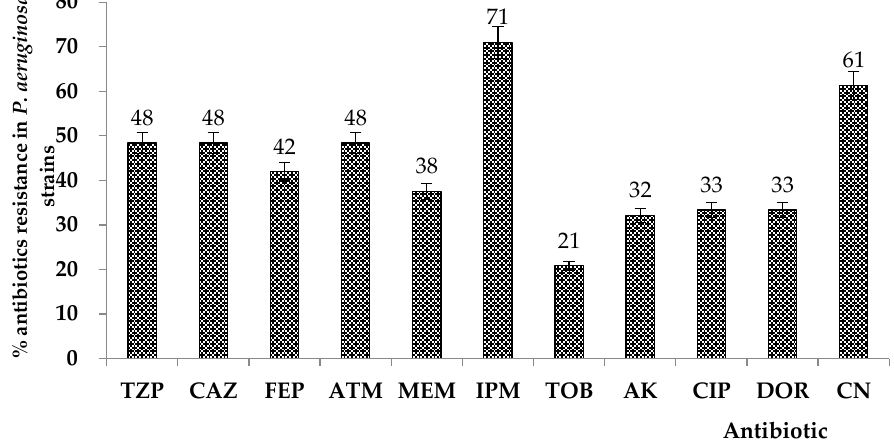
Figure 1. Results of antibiotic resistance of Pseudomonas aeruginosa -evaluated strains ( n = 36). (TZP: piperacillin/tazobactam; CAZ: ceftazidime; FEP: cefepime; ATM: aztreonam; MEM: meropenem;